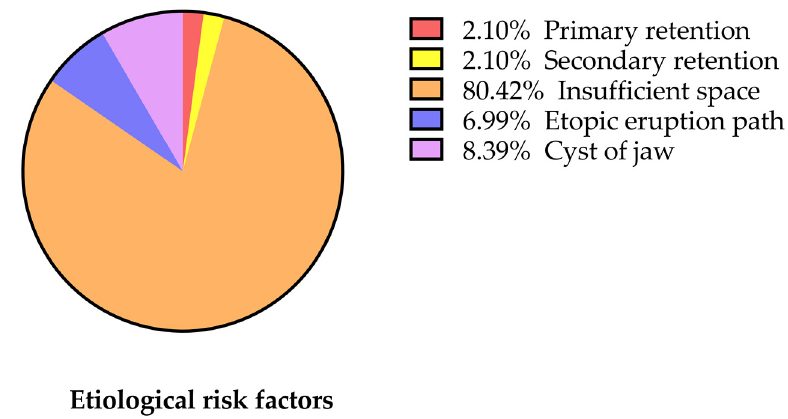
Figure 3. Etiological risk factors associated with the 143 eruption disturbances of MM2. Table 2. Demographics and baseline information of the patients based on impaction and